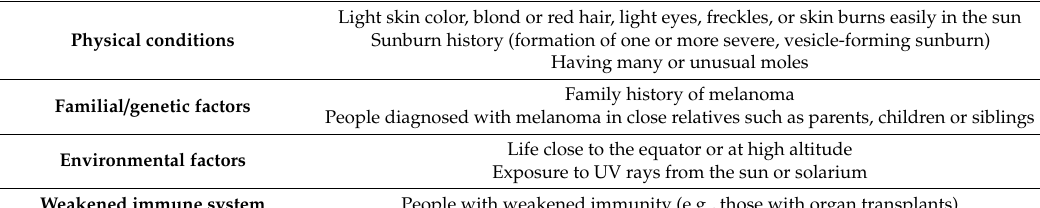
Table 2. Risk factors in the development of malignant